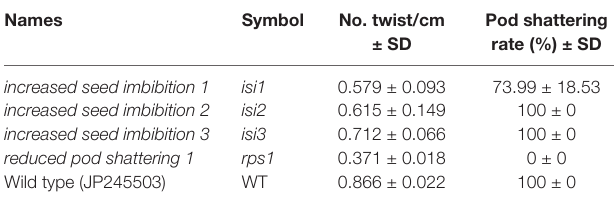
TABLe 2 | Phenotypic data of mutant